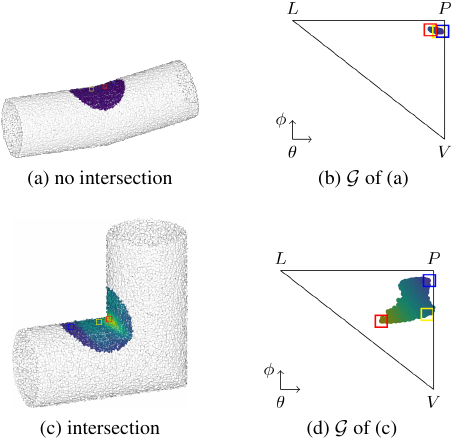
Figure 4. In (a), a cylinder slightly bent at its middle at a 10 ◦ angle, generated with an added Gaussian noise. In (b), the projection of the coloured points of (a) in G . In (c), two cylinders intersecting at a 90 ◦ angle, generated with an added Gaussian noise. In (d), the projection of the coloured point of (c) in G . In (a) and (c), coloured points are weighted by their δ value from purple to yellow. In all figures, the position of the point of interest p is shown in a yellow square, and the least and most stable points are shown in red and blue